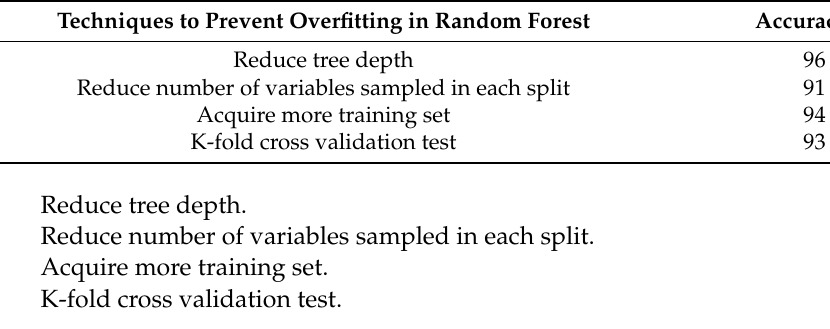
Table 10. Results of preventive techniques (random forest).